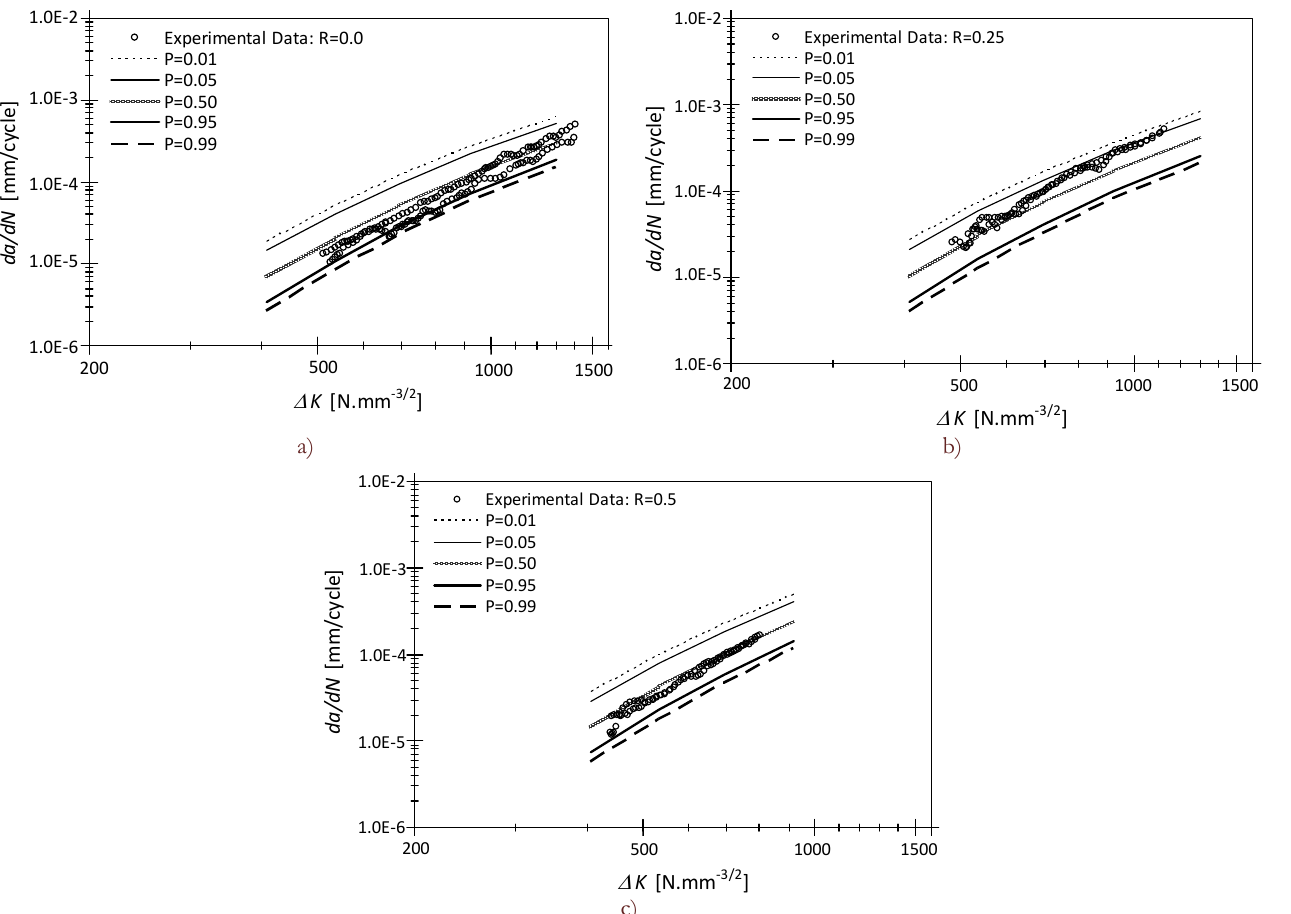
=0; b) R =0.25; c) σ σ